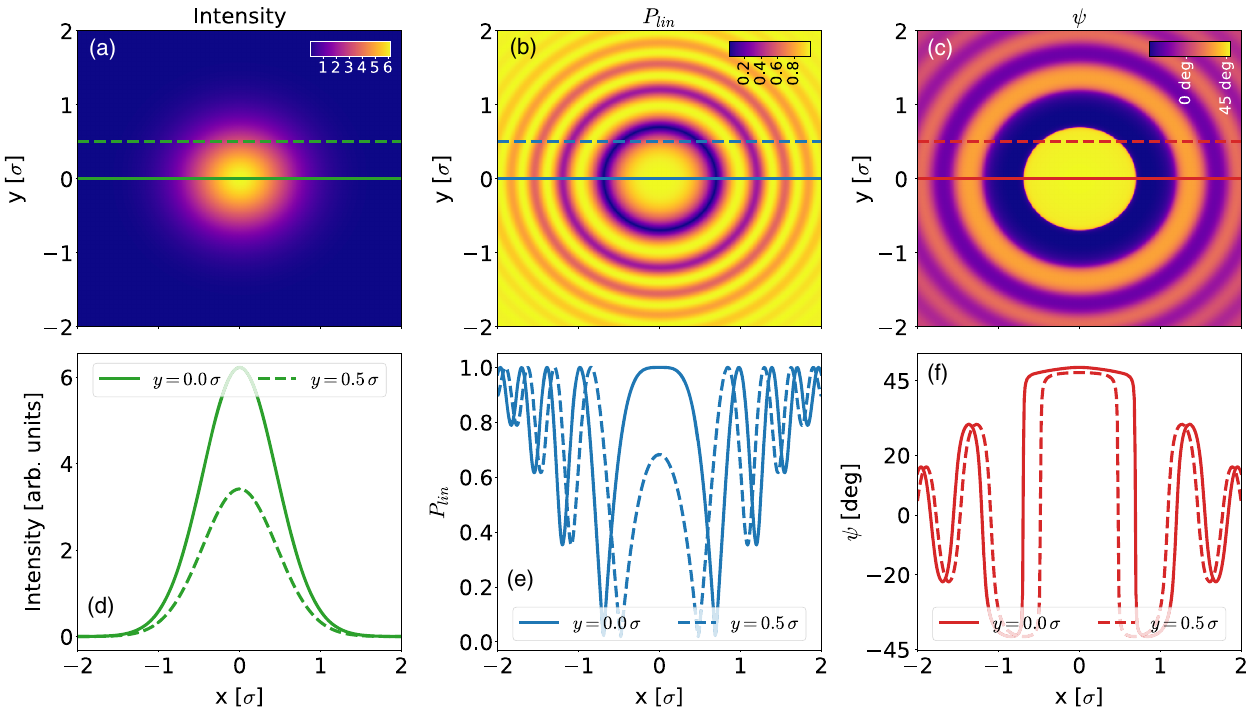
FIG. 6. False color representation of the far field intensity (a), degree (b) and direction (c) of linear polarization, for the superposition of two Gaussian beams with orthogonal polarization, namely linear horizontal and linear vertical, with phase shift an integer of the wavelength. The distance between the two sources is 3.0 z R . The above quantities are shown along the solid and dashed lines on the surfaces on the plots. One can see that the polarization properties are changing along the wavefront of the total field if the sources ’ separation is larger that the Rayleigh range of the radiation.